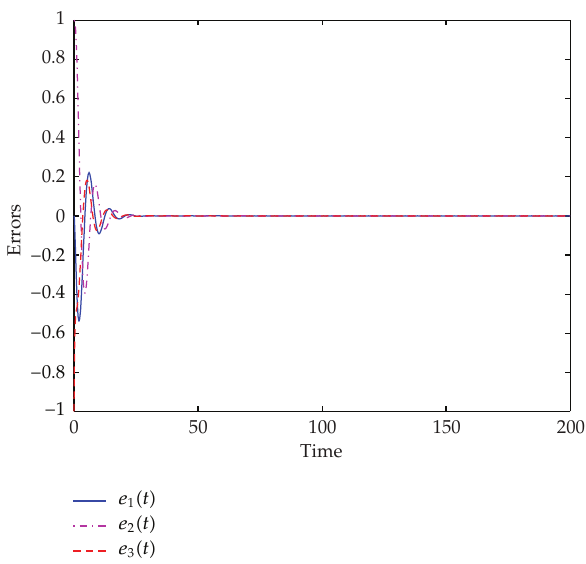
Figure 9: Synchronization errors in Case 2.